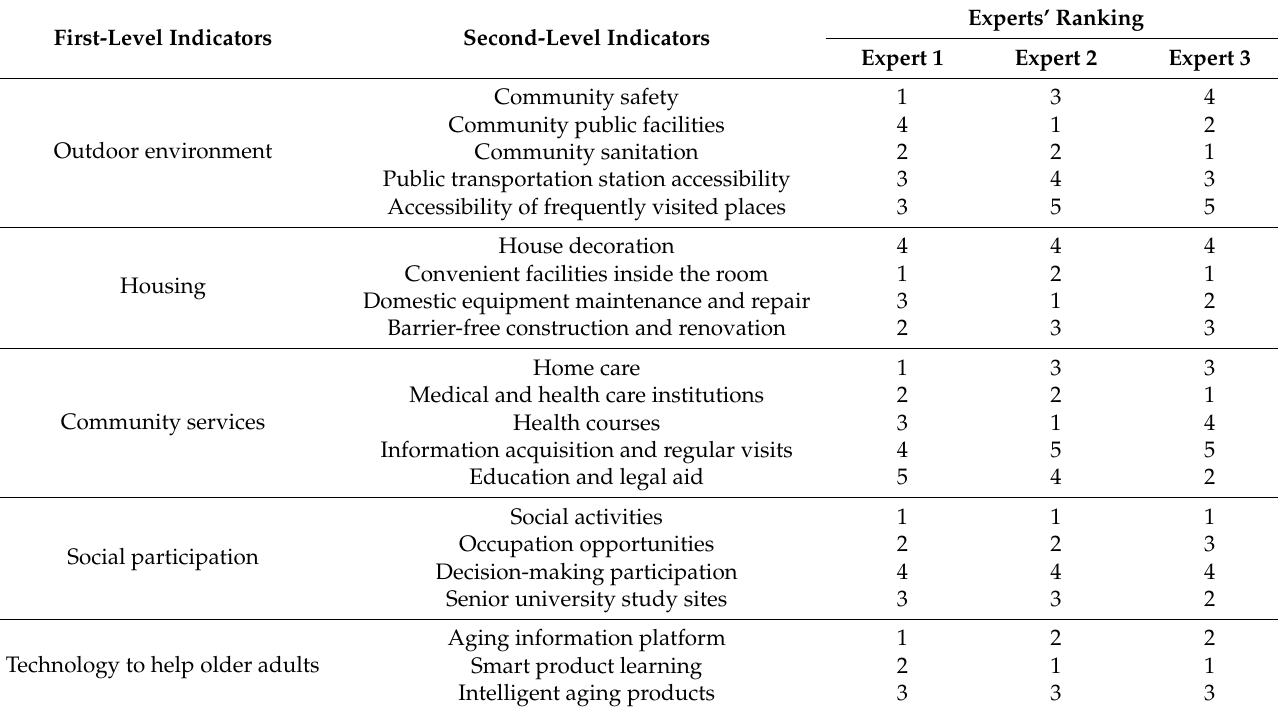
Table 4. The ranking results for the second-level indicators by